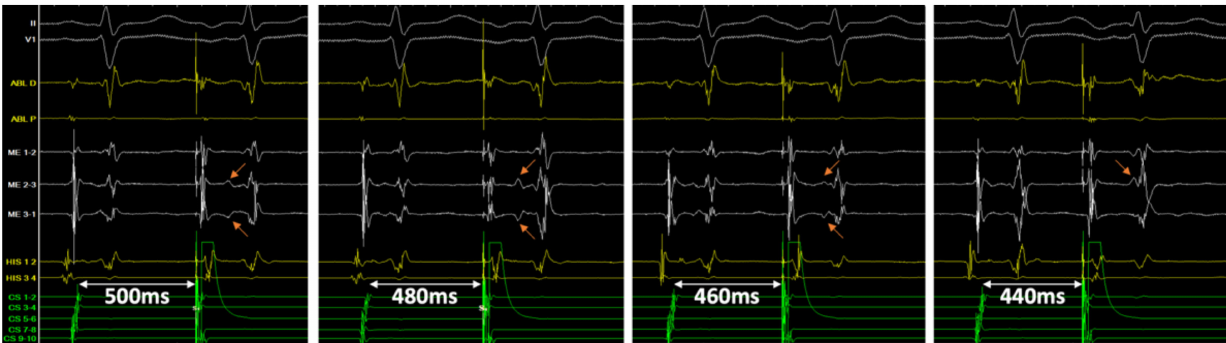
Figure 3. Tracings in patient #11 following successful ablation of the slow pathway. Double potentials can be easily identified on the mini-electrodes bipolar channels (ME 2–3 and 3–1), not on the distal ab- lation conventional bipolar tracing (ABL D). From left to right, with an atrial extra-stimulus coupling interval of 500, 480, 460 and 440 ms, the delay between sharp and slow potential (orange arrows) progressively increases from 114 to 180 ms, until it is hidden into the ventricular farfield